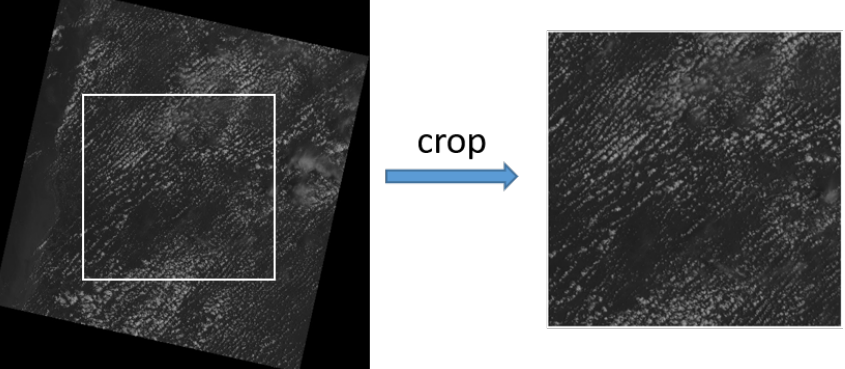
Figure 2. Lansat8 scenes are centre-cropped into 4000 × 4000 pixel images.